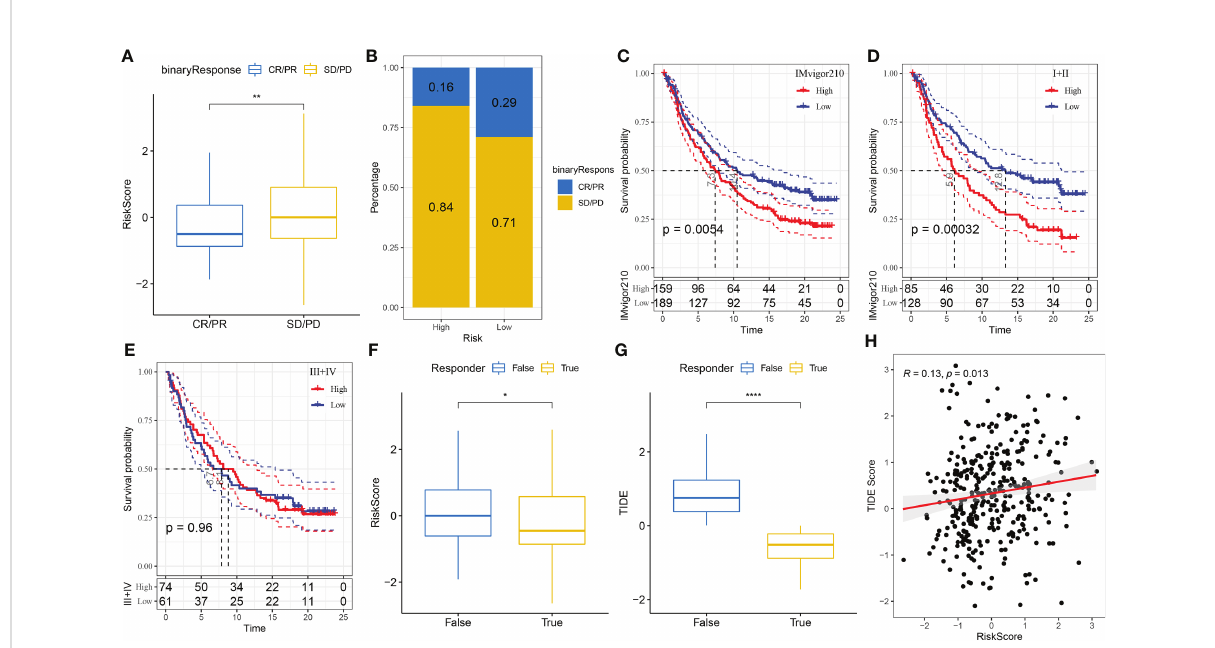
FIGURE 10 (A) Differences in immunotherapy responses and risk scores in the IMvigor210 cohort; (B) Immunotherapy response among different risk groups in the IMvigor210 cohort; (C) Prognostic differences between different risk groups in the IMvigor210 cohort; (D) Prognostic differences between different risk groups of patients with early-stage CRC in the IMvigor210 cohort; (E) Prognostic differences between different risk groups of patients with middle- and late-stage CRC in the IMvigor210 cohort; (F) Differences in immunotherapy response and different risk scores in the IMvigor210 cohort were analysed using the TIDE software; (G) Differences in TIDE scores and immunotherapy responses in the IMvigor210 cohort; (H) Correlation analysis between the risk and TIDE scores in the IMvigor210 cohort. *P< 0.05, **P < 0.01, ****P <